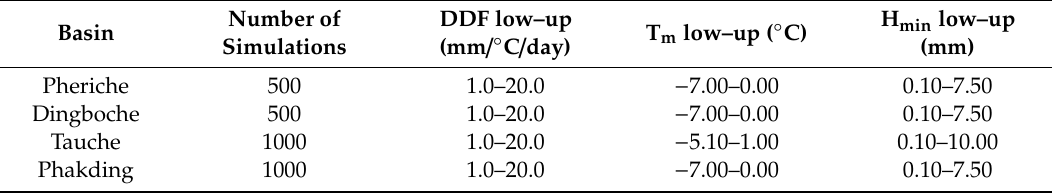
Table 4. Choices in parameter space discretization for optimization set-up: Number of simulations and ranges for temperature threshold (T m ), snowmelt degree day factor (DDF), and minimal snow height threshold (H min ) for the four basins studied. The lower boundary is indicated by “low” and the upper by